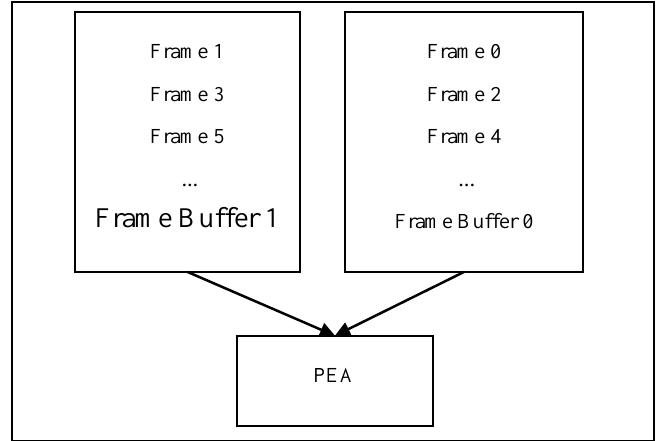
Figure 4. An implementation of Inter-E for